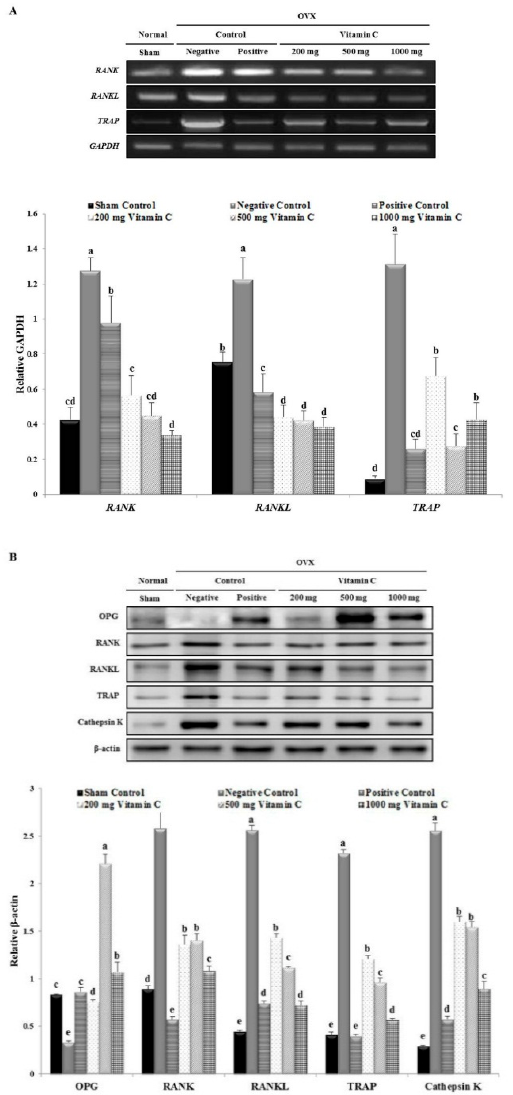
Figure 6. The effect of vitamin C on the expression of osteoclast differentiation-specific genes and proteins in the tibia. ( A ) RT-PCR products of osteoclastogenesis-related genes. Quantitative assay of mRNA expression levels of RANK , RANKL , and TRAP in vitamin C-treated rat tibias. ( B ) Western blot image of osteoclastogenesis-related proteins and the quantitative assay of OPG, RANK, RANKL, TRAP, and cathepsin K protein expression in vitamin C-treated rat tibias. Expression was quantified using ImageJ software relative to glyceraldehyde 3-phosphate dehydrogenase (GAPDH) and β -actin expression. Values represent the mean ± standard deviation. Values with different letters were significantly different according to Duncan’s multiple range test ( P < 0.05).